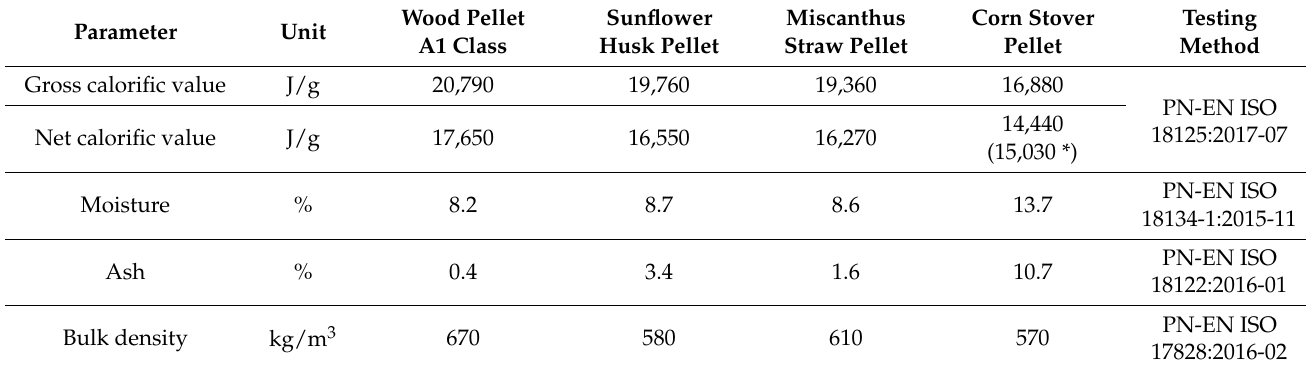
Table 1. Characteristics of the tested